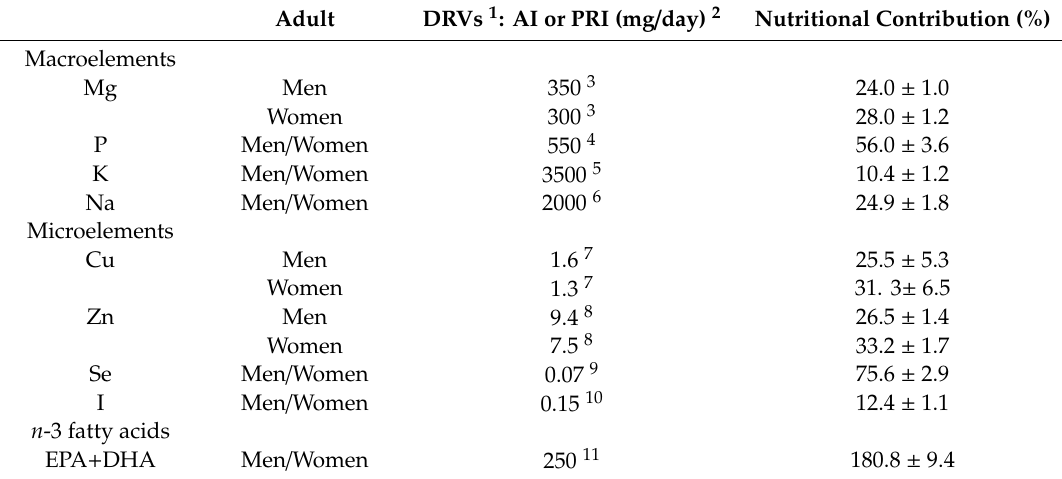
Table 8. Nutritional contribution (%) of boiled common octopus in terms of mineral elements and EPA + DHA, taking into account a meal portion of 150 g. Adult DRVs 1 : AI or PRI (mg / day) 2 Nutritional Contribution